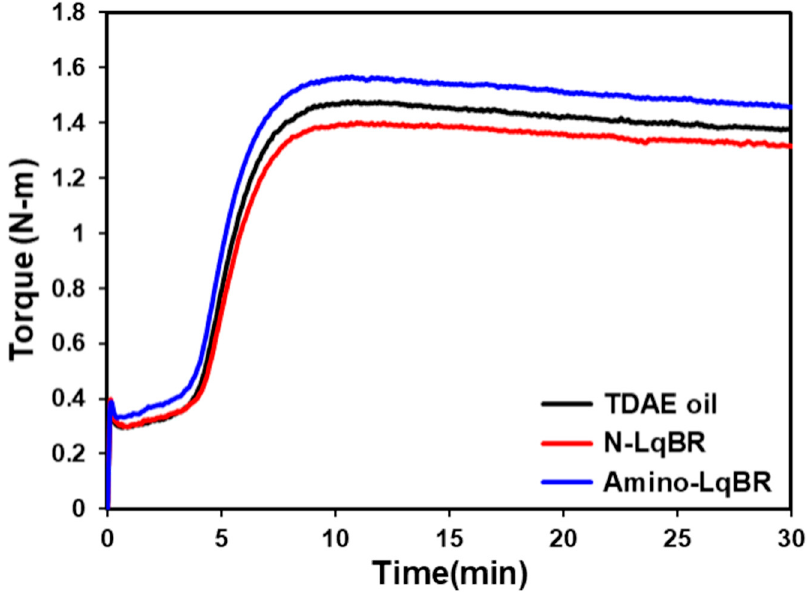
Figure 6. Cure characteristics of the compounds according to the applied processing aids.